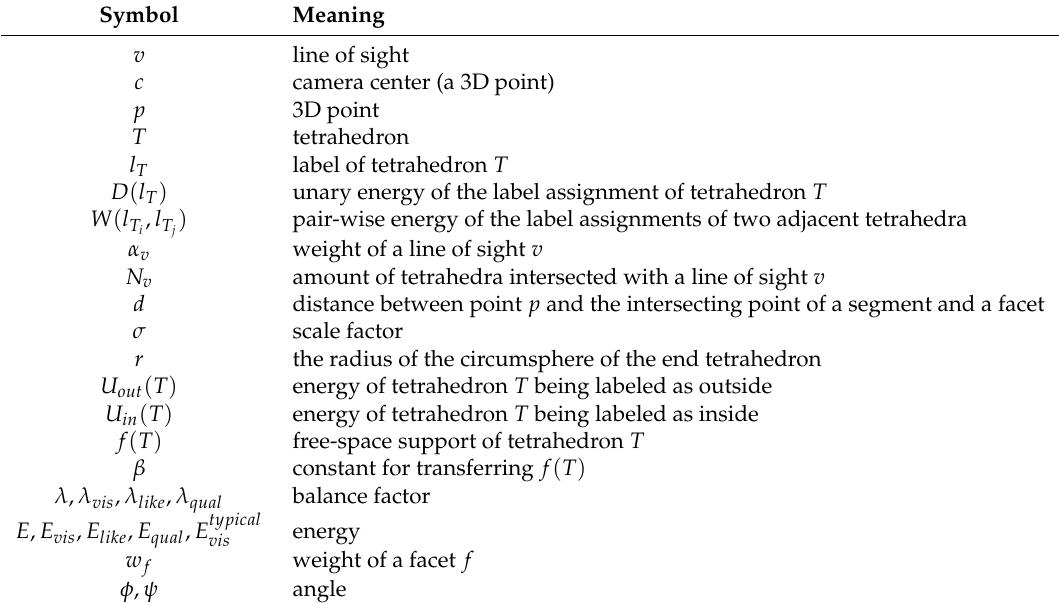
Figure 2. Pipeline of the proposed method in 2D. From left to right are the input point cloud, Delaunay tetrahedra, the s - t graph, the energy minimization result and the final surface mesh. Table 1. Symbols used in this